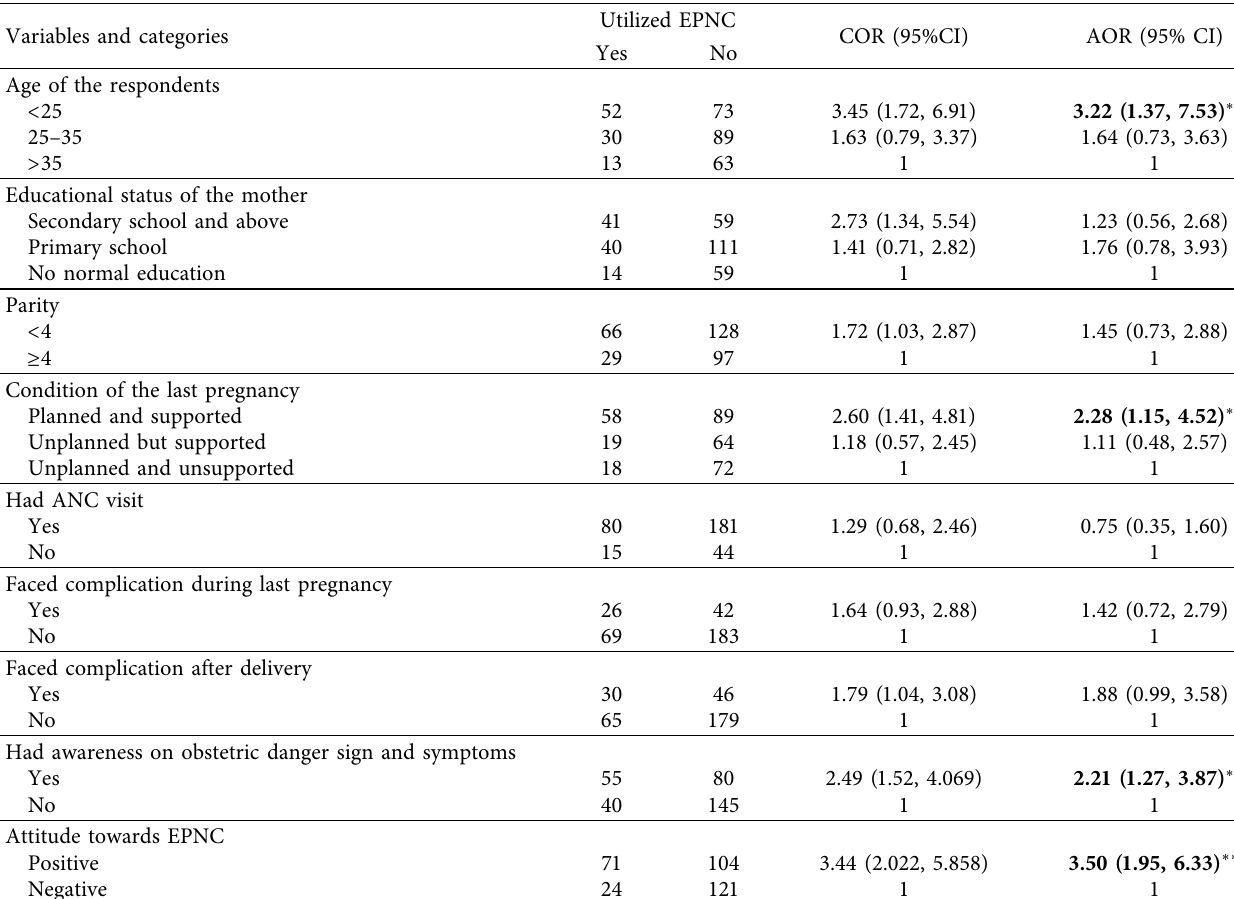
Table 5: Factors associated with EPNC service utilization in Hawassa Zuria district, Sidama Regional State, Ethiopia, 2020. Variables and categories